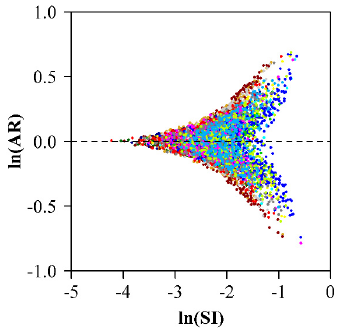
Figure 7. Fishtail plot for leaf bilateral symmetry. The smaller the ln(SI), the more bilaterally symmetric the leaf is. If ln(AR) is equal to 0, it indicates that the areas of the left side and that of the right side of a leaf are equal (Figure 2 for calculation). ln(AR) can provide information on whether the area of the left side is equal to that of the right side of a leaf, but it cannot be used to measure the strict bilateral symmetry for a leaf. Different colors represent different species of vines, and each point corresponds to a single leaf.